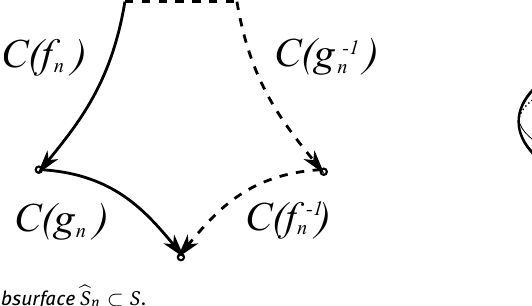
Figure 8: Subsurface (cid:98) S n ⊂ S